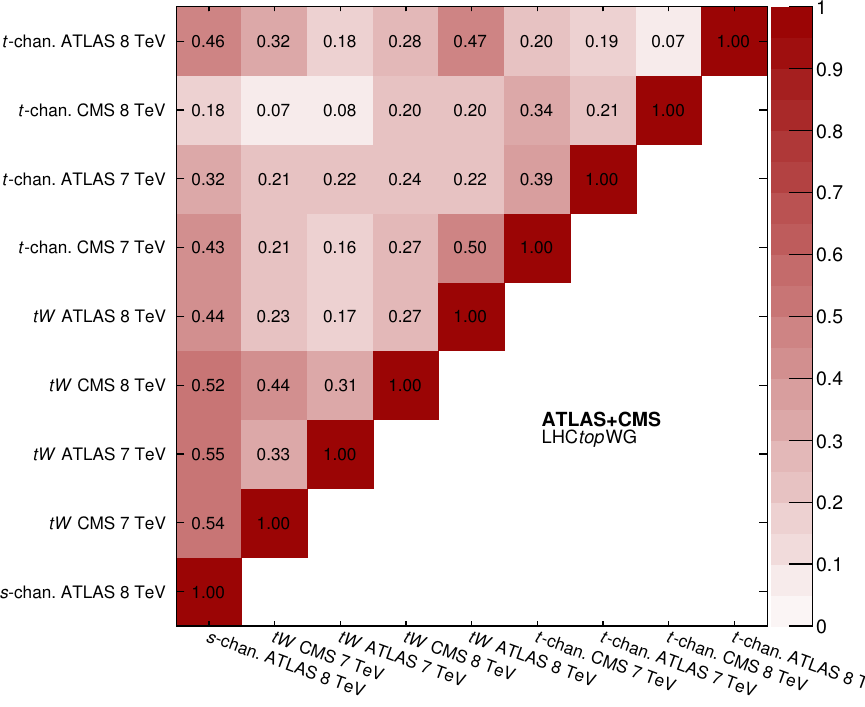
2 combination. Each bin corresponds to a f LV V tb j j